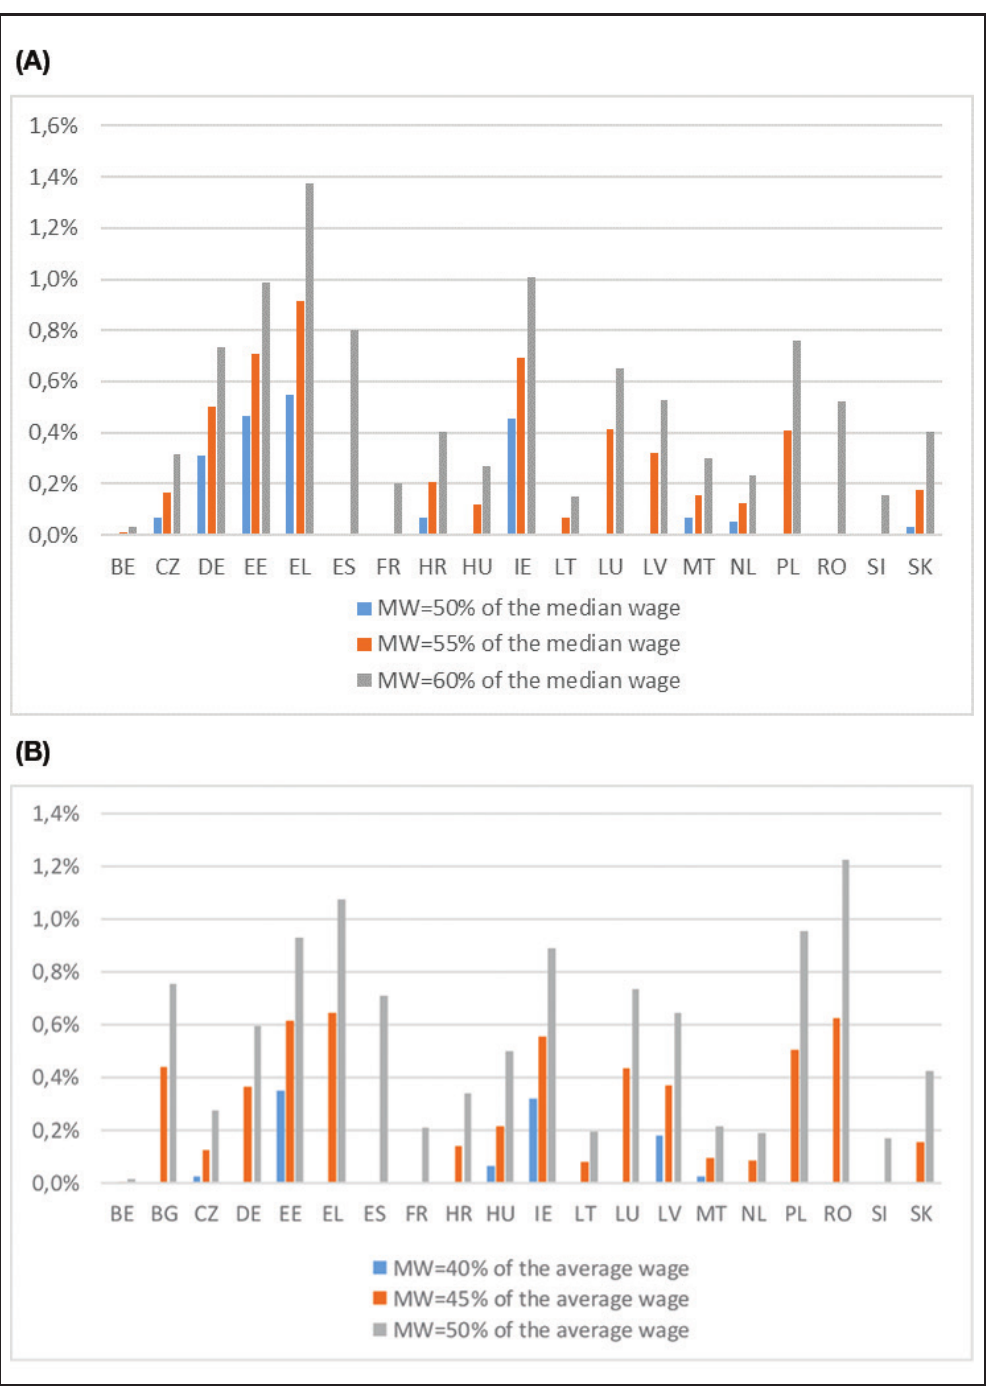
Figure A11 Estimation of possible negative employment effects in simulated HMW